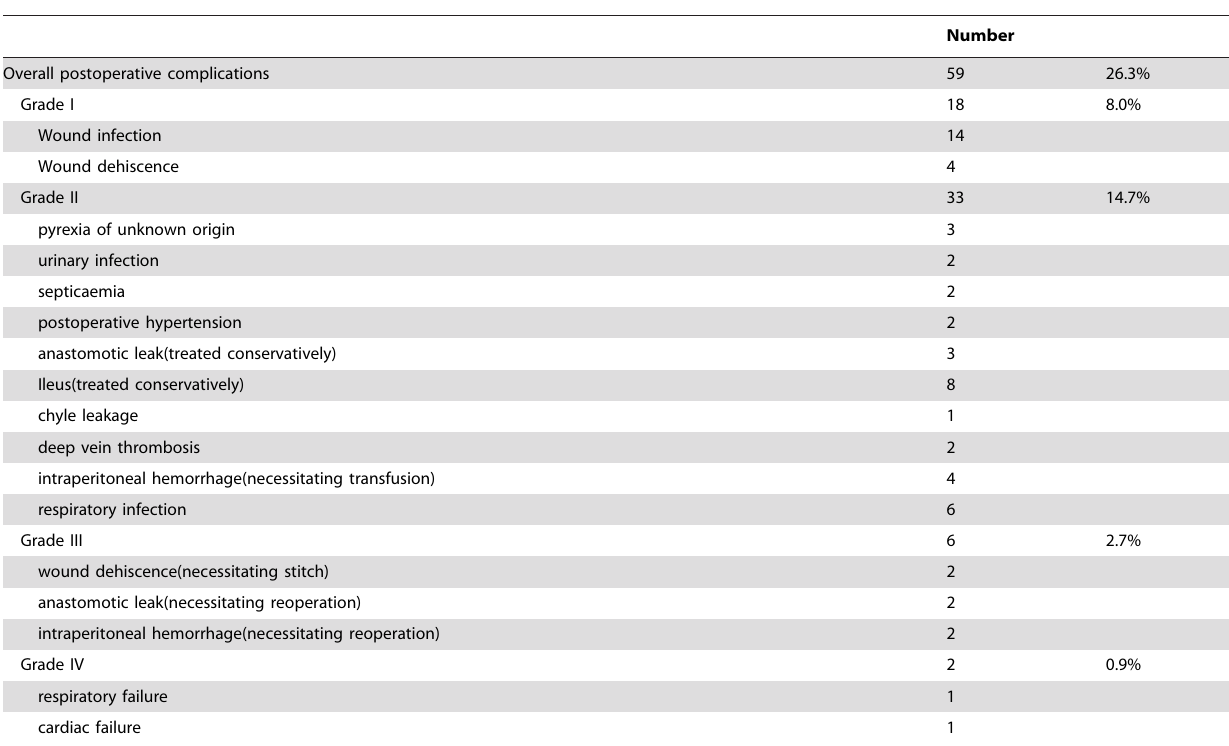
Table 1. Elaboration of Postoperative